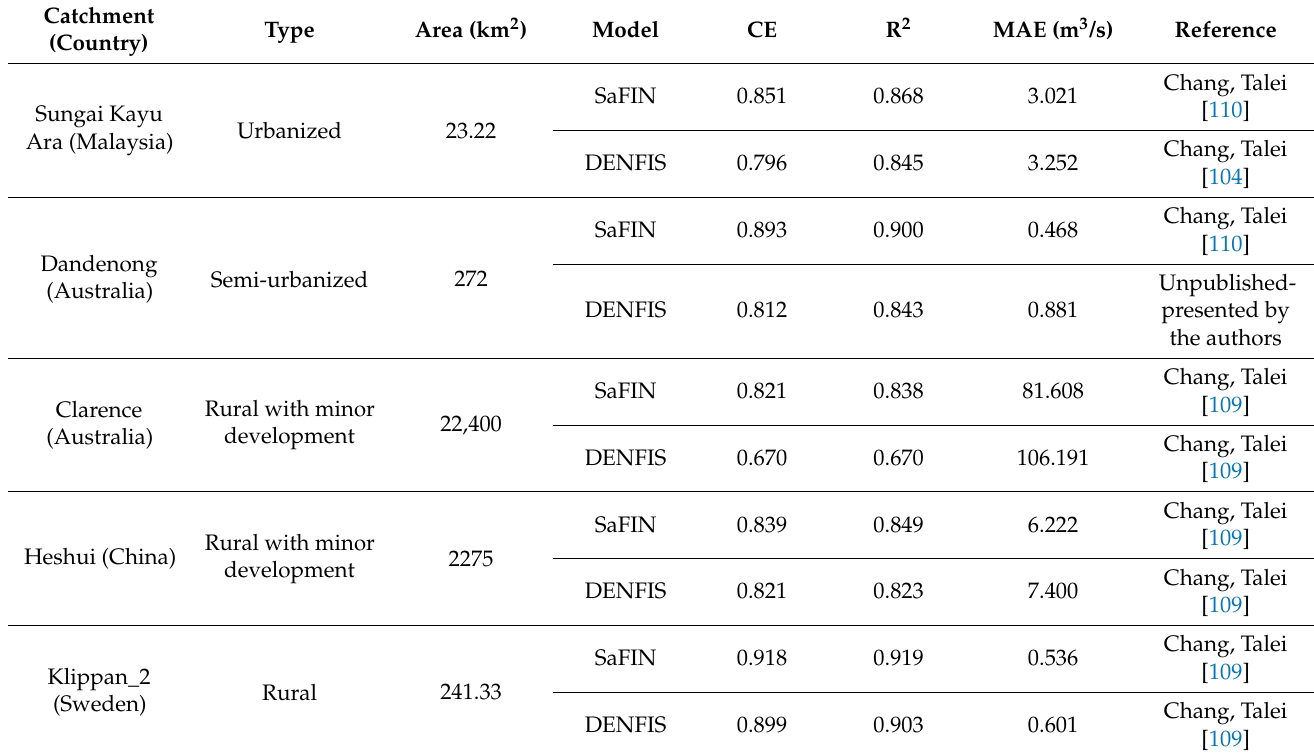
Table 1. SaFIN and DENFIS performances for rainfall–runoff modeling in catchments with different sizes and